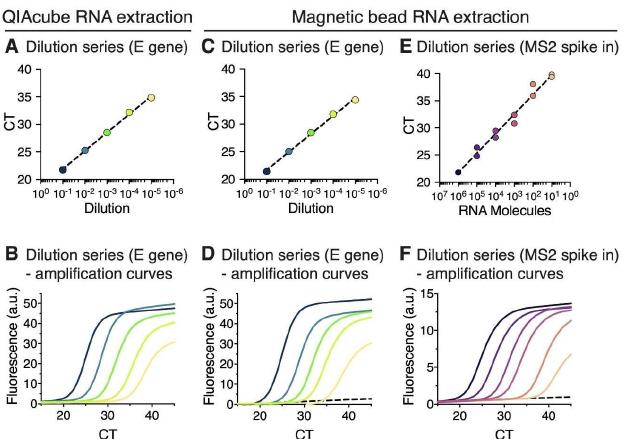
Figure 3. RT-qPCR of RNA extracted from sample dilution series using either the QIAcube RNA extraction kit or the magnetic beads RNA extraction. ( A – D ) One positive patient sample was diluted in a 10-fold dilution series from 10 1 to 10 5 fold (dark blue—green—yellow). ( A ) RT-qPCR cycle threshold (CT) values of RNA extracted using the QIAcube RNA extraction protocol shown on a semi-logarithmic scale. Semilog non-linear regression shows a goodness of fit of R 2 = 0.998. ( B ) RT-qPCR amplification curves of RNA extracts shown in ( A ); a.u., arbitrary units. ( C ) RT-qPCR CT values of RNA extracted using the magnetic bead RNA extraction protocol shown on a semi-logarithmic scale. Semilog non-linear regression shows a goodness of fit of R 2 = 0.996. ( D ) RT-qPCR amplification curves of RNA extracts shown in ( C ). Dashed black line shows an undiluted RNA sample from a SARS-CoV-2 negative patient. ( E , F ) Analysis of linearity and detection sensitivity of the magnetic bead RNA extraction protocol using MS2 RNA spike-in. Dilution series of MS2 RNA from 10 1 to 10 6 (black—purple—orange), was added into SARS-CoV-2 positive patient samples prior to magnetic bead RNA extraction. (E) CT values for each dilution (duplicates) were plotted against calculated molecule numbers of MS2 RNA per RT-qPCR reaction on a semi-logarithmic scale. All data points and the semilog non-linear regression with a goodness of fit of R 2 = 0.980 are shown. ( F ) RT-qPCR amplification curves of diluted MS2 RNA extracts shown in ( E ) for one duplicate. Dashed black line is a sample without MS2